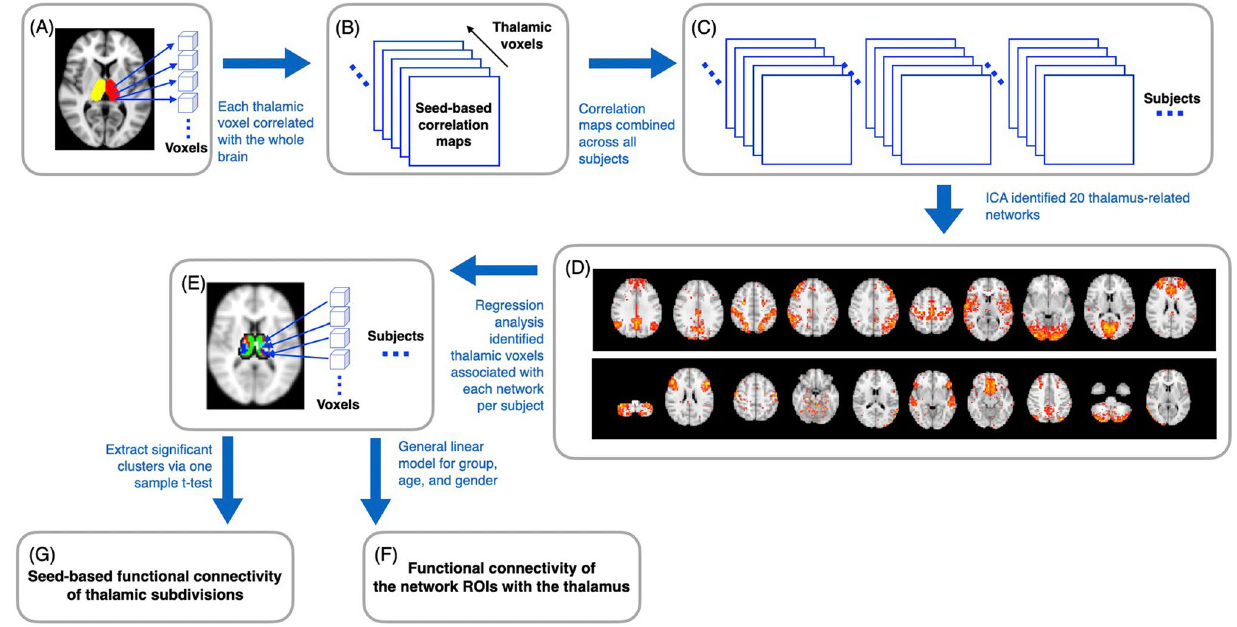
Figure 4. Schematic flow of the thalamocortical functional connectivity